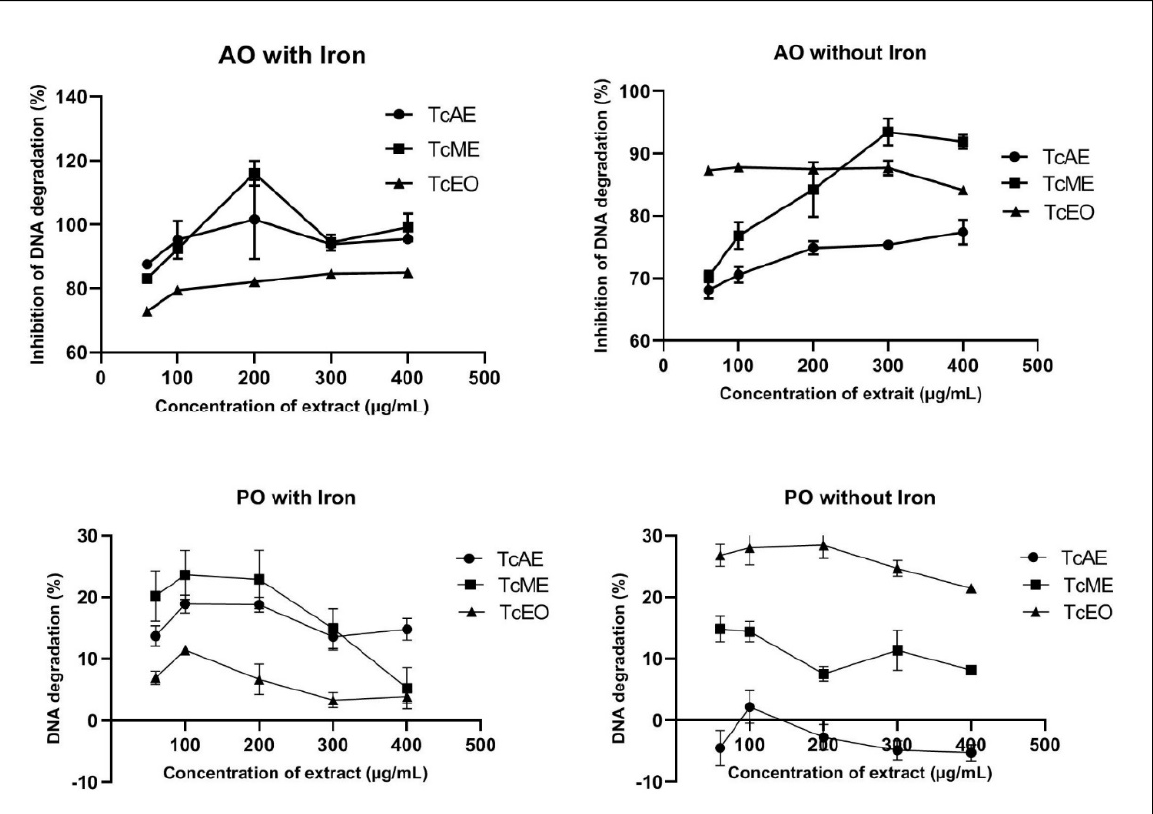
Figure 5. Assessment of inhibition DNA degradation and DNA degradation in AO and PO assays at different concentrations of Thymus capitatus extracts. different concentrations of Thymus capitatus